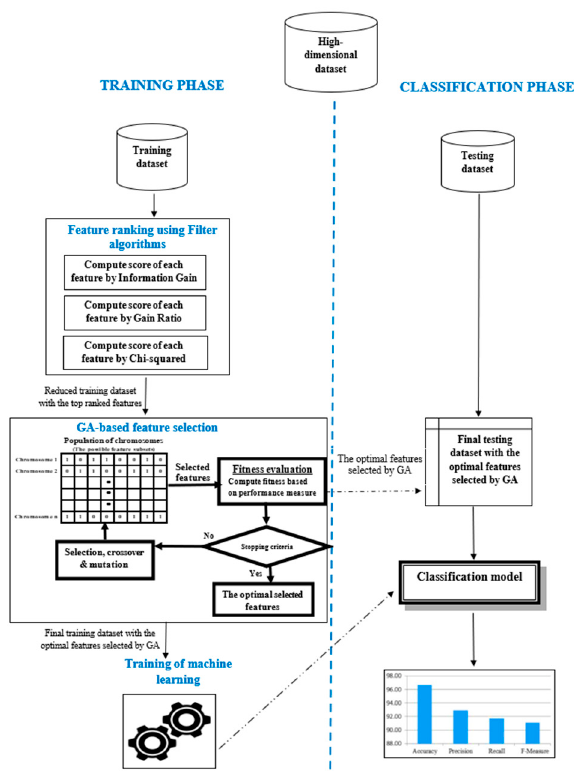
Figure 1. The methodology of the hybrid filter genetic algorithm-based feature selection approach proposed for cancer classification in high-dimensional microarray datasets.